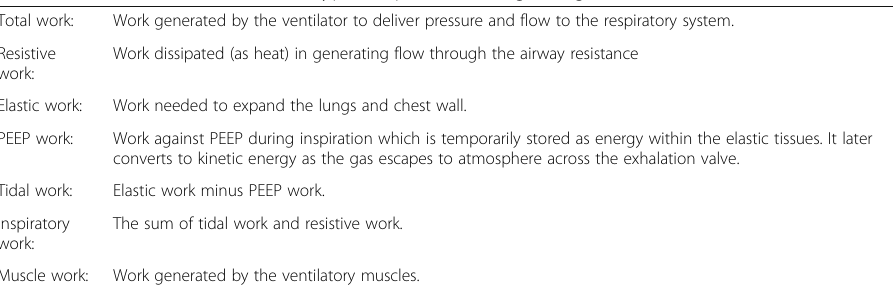
Table 1 Definition of the different types of power relating to Fig. 2